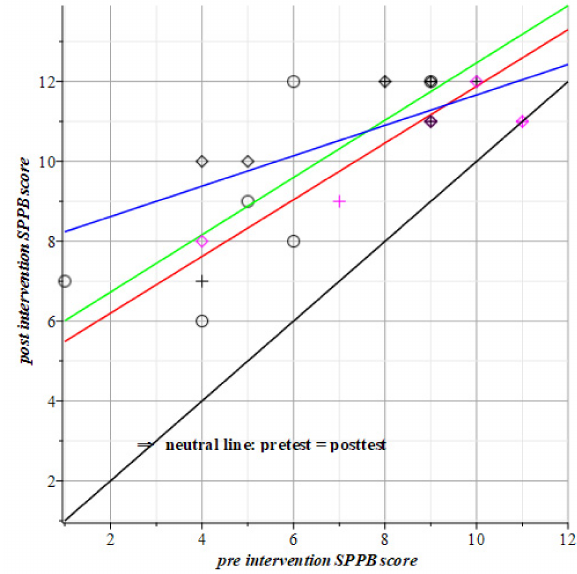
Figure 5. The mean results of the motor intervention are green; the visuo-spatial-motor intervention mean line is blue; the red line is the control group; the no-results, or neutral line is black. All groups are above the black line, so they all made progress, compared to their respective pre-intervention scores. The visuo-spatial-motor group performs better until break even (SPPB = 8). The motor group performs better after SPPB = 8. Red datapoints represent male subjects. Circles and green line: Motor group, T 1 = 5.29 ( ± 1.81) + 0.72 ( ± 0.31) T 0 ( SPPB ) . Rhombus pts., blue: Visuo-spatial-motor group, T 1 = 7.86 ( ± 0.95) + 0.38 ( ± 0.12) T 0 ( SPPB ) . Plus signs, red line: Control group, T 1 = 4.78 ( ± 1.56) + 0.71 ( ± 0.18) T 0 ( SPPB ) .